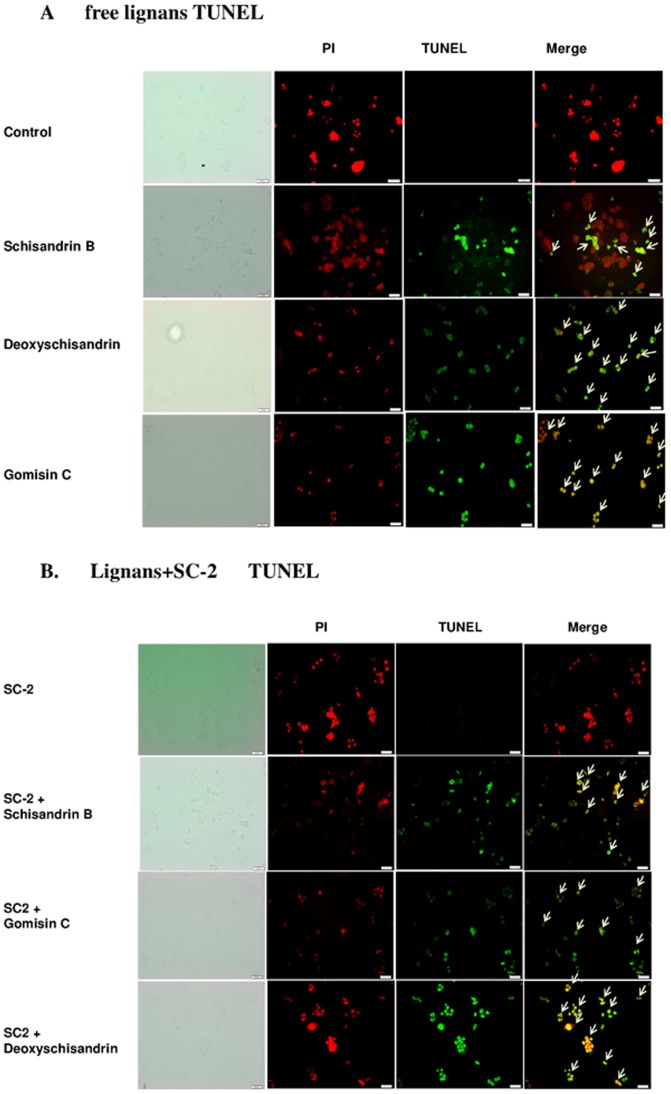
TUNEL assay for HepG2 cells.Cells treated with free lignans (A), and lignan plus SC-2 (B). Cells were induced for 24 h, then PI staining and TUNEL assay were carried out. Results were examined under a fluorescence microscope (×400).